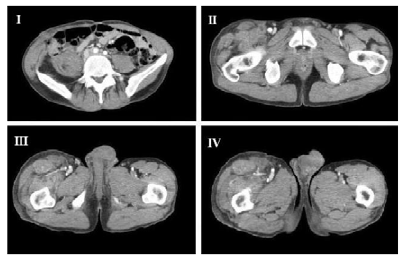
Figure 2. Postoperative computed tomography showing the outcome of the treatment. The psoas muscle has been spared despite the resection of the cysts (I, II); the right thigh is free of cysts with the conservation of the muscular structures (III, IV).